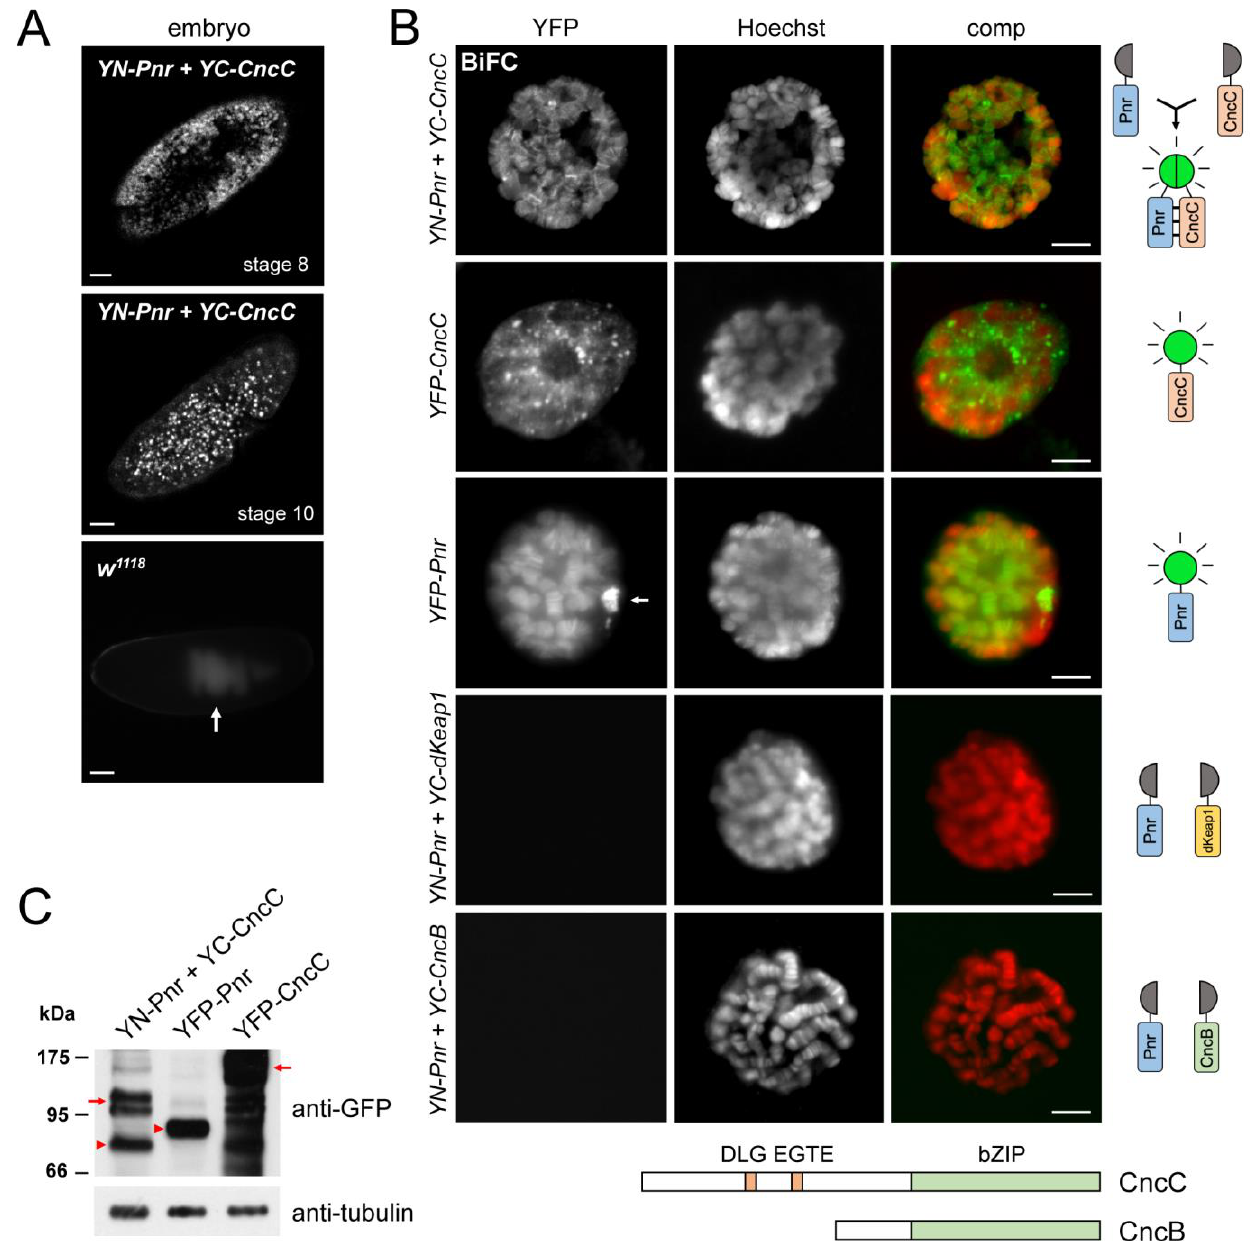
Figure 1. Visualization of CncC–Pnr BiFC complexes in live cells: ( A ) Formation of CncC–Pnr BiFC complexes in the embryo. YC–CncC and YN–Pnr fusion proteins were expressed using the tub-GAL4 driver. Intrinsic BiFC fluorescence was imaged in dechorionated live embryos at the stages indicated. The fluorescence represented specific BiFC complexes as indicated by comparison to wild-type ( w 1118 ) embryos with the same exposure. Arrow: autofluorescence produced by yolk. Scale bars: 50 µ m. ( B ) Visualization of CncC–Pnr BiFC, YFP–CncC, and YFP–Pnr in salivary gland cells. Fusion proteins described on the left were expressed using the Sgs3-GAL4 driver. Salivary glands were dissected and stained with Hoechst (red). BiFC fluorescence or intrinsic YFP fusion proteins (green) were imaged. Diagrams on the right depict the CncC–Pnr BiFC complex in comparison with YFP fusion proteins. As controls, YC–dKeap1 or YC–CncB were co-expressed with YN–Pnr, and no BiFC signal was detected. The bottom diagram depicts the comparison of the CncC and CncB protein